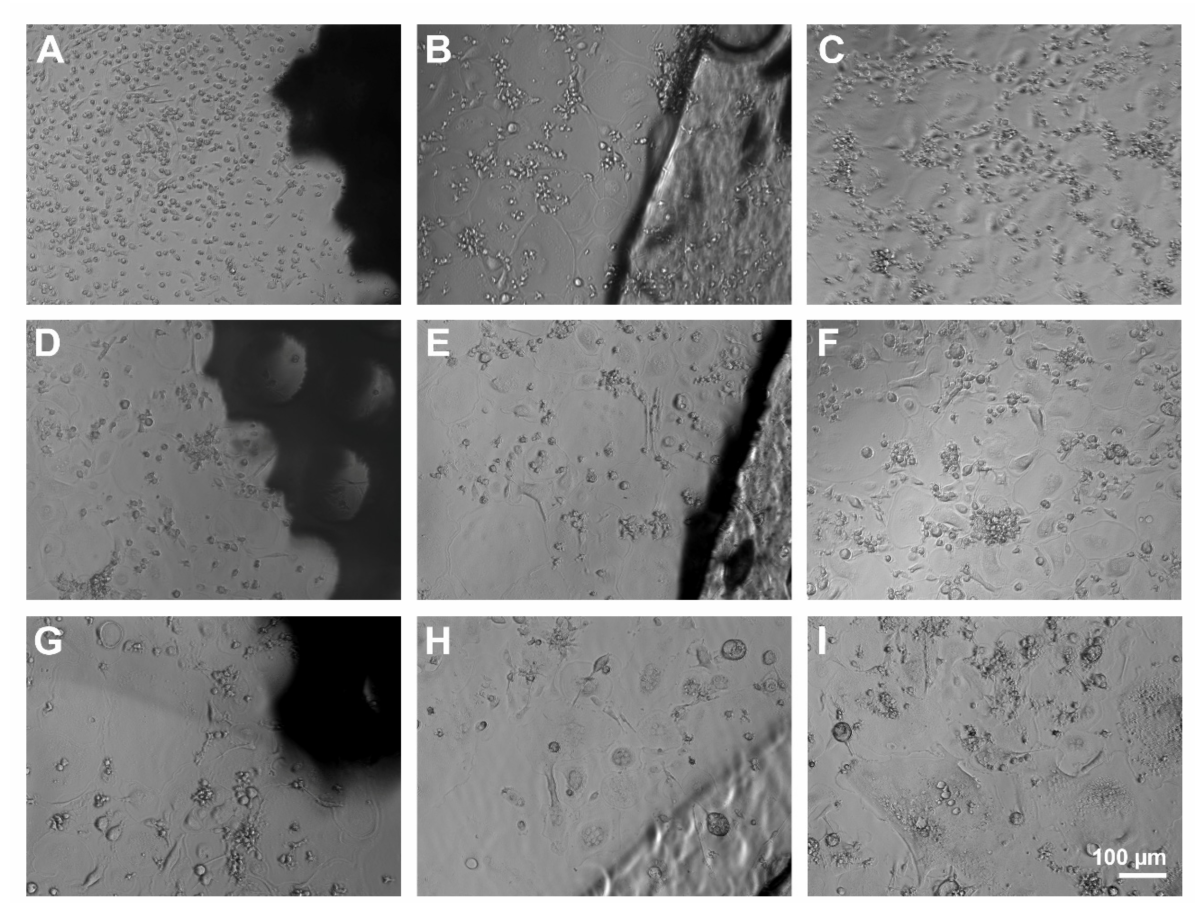
Figure 10. Light microscopic observation of PBMC and osteoclasts after 4 ( A – C ), 8 ( D – F ), and 12 days ( G – I ) at the interface of PS ( A , D , G ), CS ( B , E , H ), and pure cell culture plastic (control, C , F , I ). Scale bar of I is representative for ( A – H